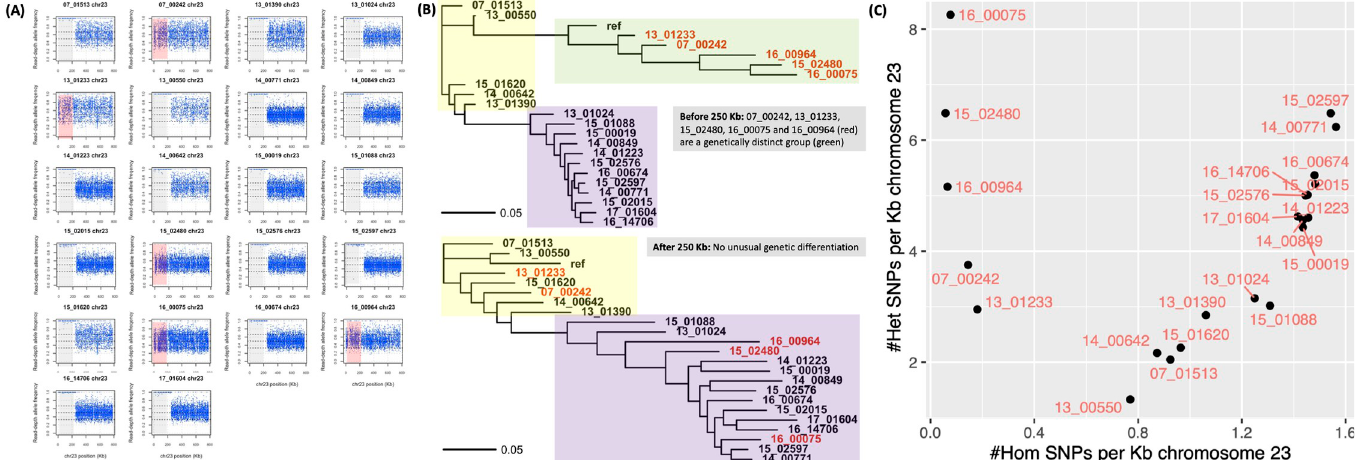
Fig 6. RDAF distributions (A) and phylogenies (B) constructed from SNPs at chromosome 23 at 0–250 Kb (grey and red in RDAF plots, top phylogeny) and > 250 Kb (uncoloured RDAF, bottom phylogeny) showing the relatedness of the 22 isolates with the L . tropica reference genome (“ref”). This showed unique ancestries at chromosome 23 at 0–250 Kb with patterns related to the L . tropica reference in 07_00242, 13_01233, 15_02480, 16_00075 and 16_00964 (red in RDAF plots, red in phylogenies) and different patterns in the other 17 isolates. The inferred genetically distinct groups are represented by the L . tropica reference (yellow area) and non- reference groups (purple area). (C) The homozygous (x-axis) and heterozygous (y-axis) SNPs per Kb for all 22 samples.